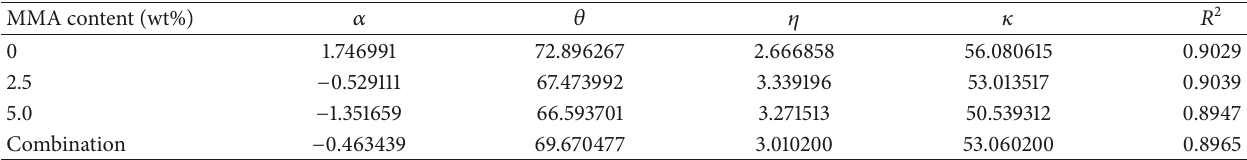
Table 13: Parameters derived from